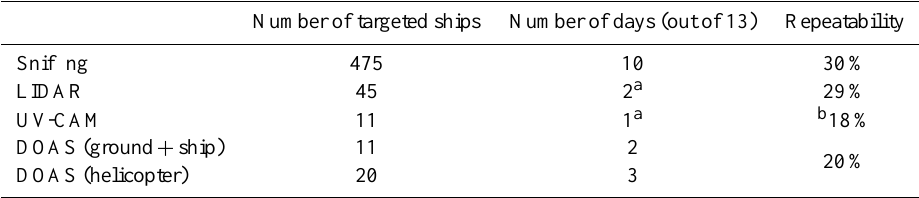
Table 2. Overview of the number of ships measured by different techniques during the SIRENAS-R campaign. Relative errors observed by repeated measurement are indicated in the last column (repeatability). Note, this value for sniffing technique reflects the repeatability of fuel sulphur ratio, while in the optical cases indicates only the uncertainty of sulphur emission rate. Uncertainty of fuel sulphur ratio is increased by the uncertainty of fuel consumption that is generally a high